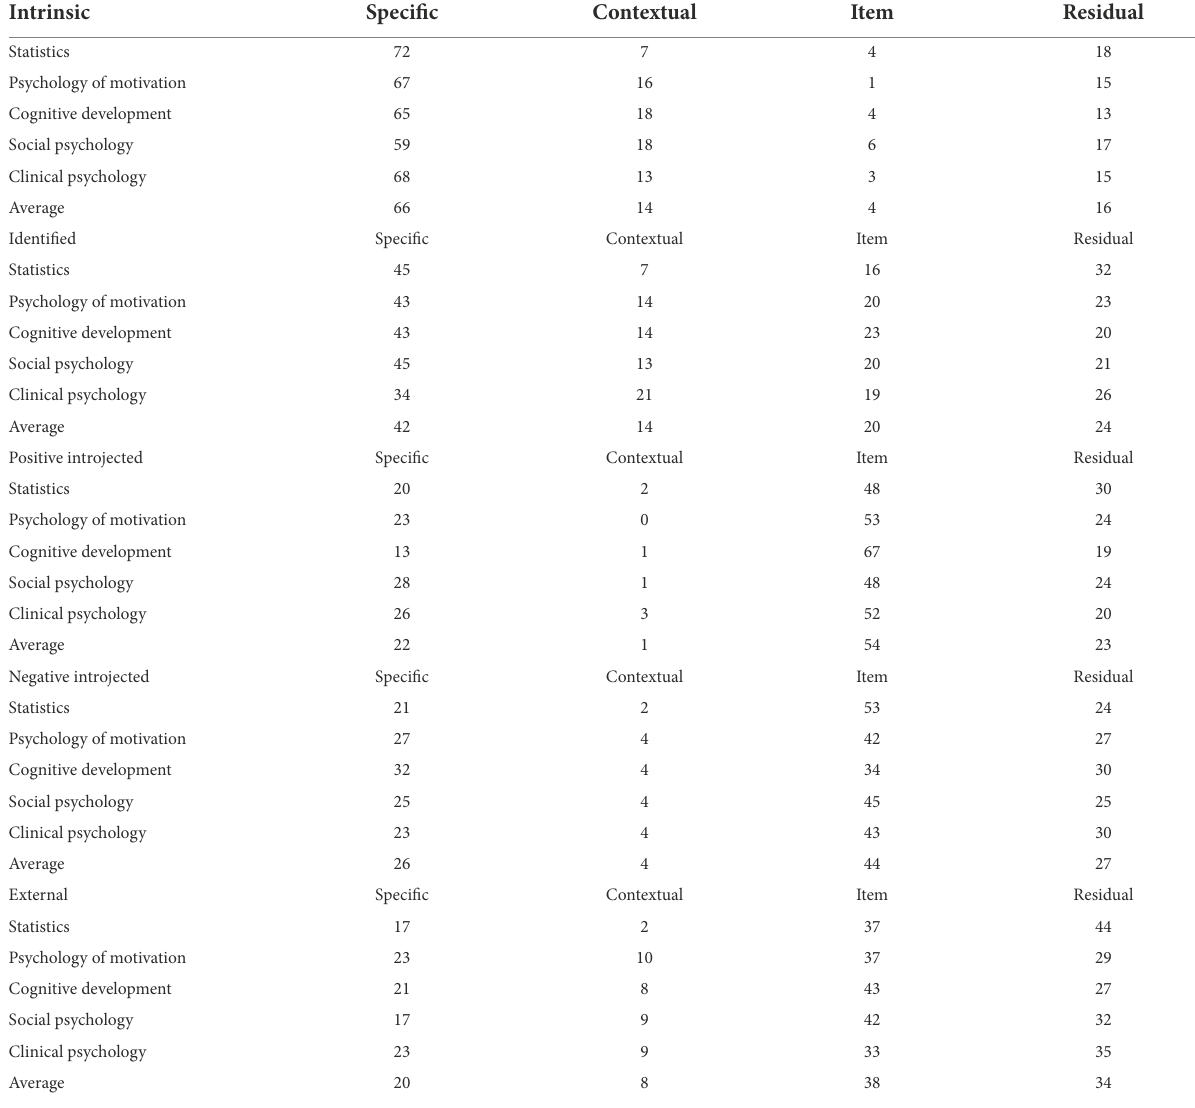
TABLE 4 Percentage of the variance due to situational (specific), contextual and item levels on average and for each course by motivation type.